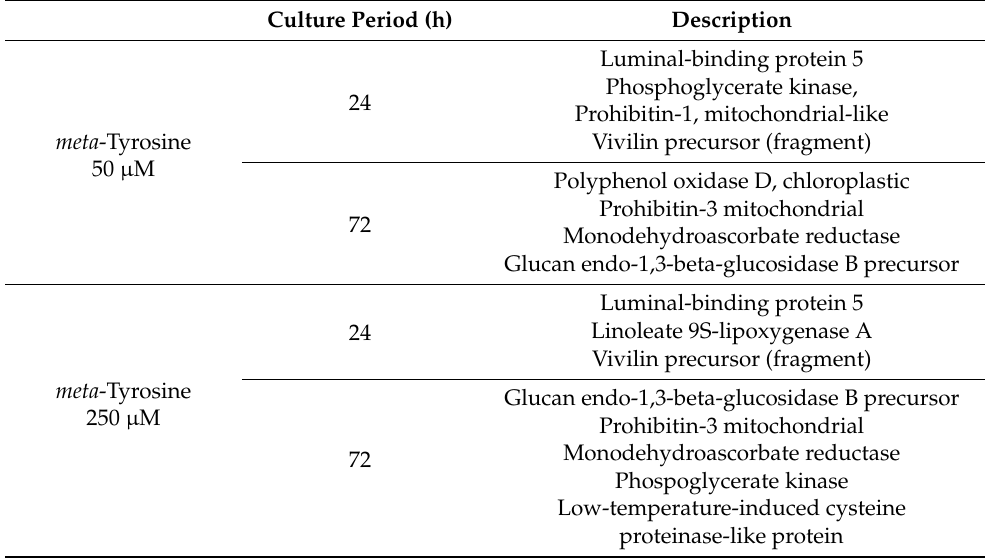
Table 2. MALDI MS/MS identification after trypsin in-gel digestion of the nitrated proteins of tomato roots treated with meta -tyrosine (50 and 250 µ M) for 24 or 72